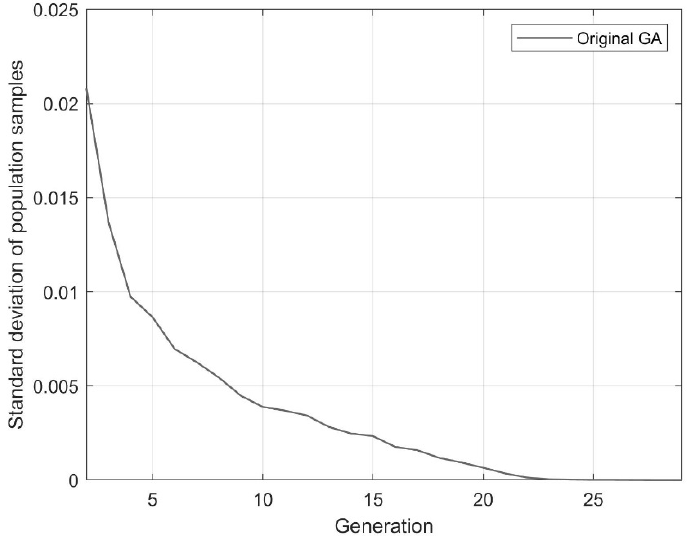
Figure 13. Standard deviation of the objective function of population members for each generation.